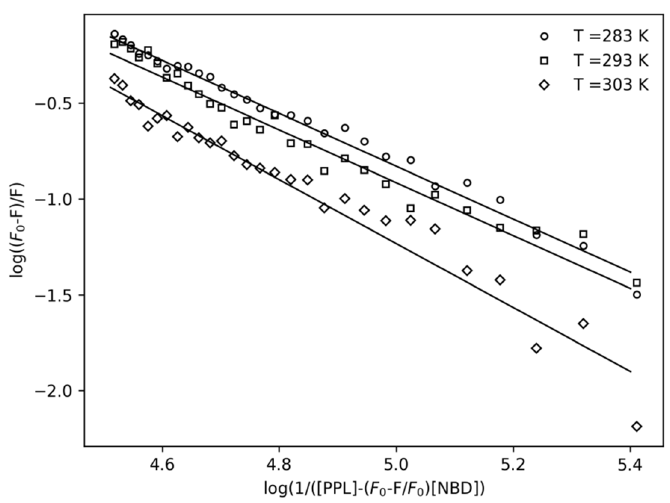
Figure 3. Double-log plots for the fluorescence quenching of NBD (4.0 µ M) by the presence of PPL at 283 K, 293 K, and 303 K.